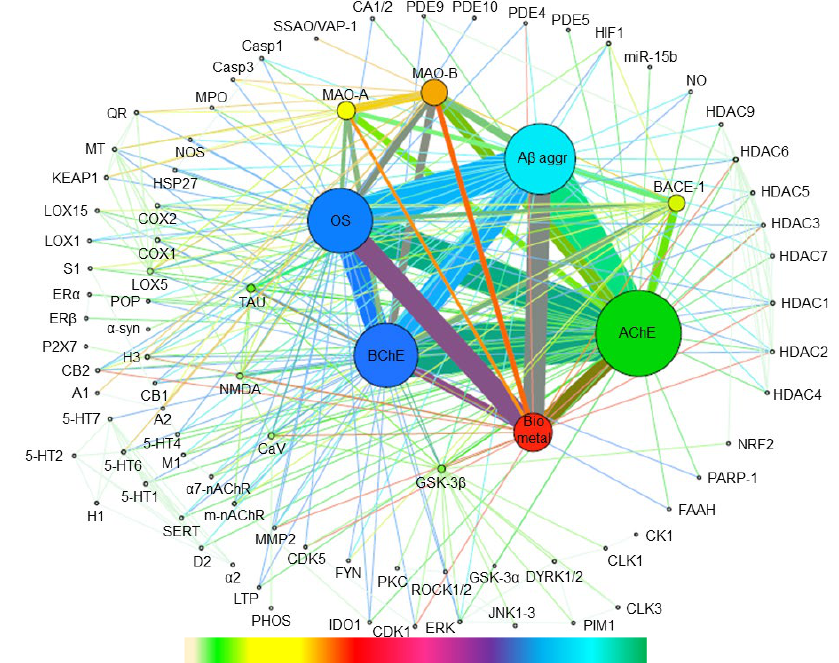
Figure 9. Mapping of the binary combinations of biological targets that have been pursued in multitarget anti-AD compounds in the period 1990–2020. For the abbreviations of the names of the biological targets, see Table 1. Individual targets and binary combinations between targets appear as nodes and edges connecting each pair of nodes, respectively. The size of the nodes and the thickness of the edges are proportional to the number of times that each individual target appears in a binary combination and to the number of times that each binary target combination has been pursued, respectively. Color codes have been used to distinguish ranges of frequency in targets and target combinations: gradient bar chart (down), from lower frequency (left) to higher frequency (right). Table 1. List of biological targets pursued in multitarget anti-AD agents and their abbreviations.